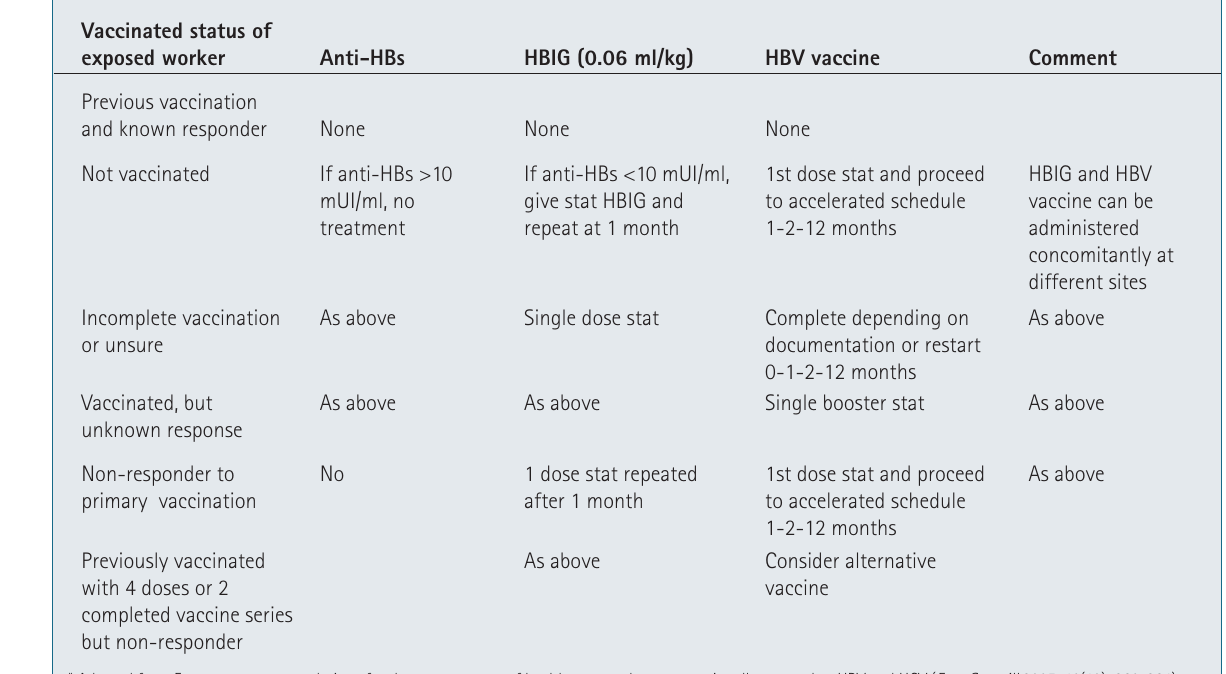
tabLe ii. manaGement oF worKer exPoSeD to an hbsag-PoSitiVe or unKnown SourCe* N